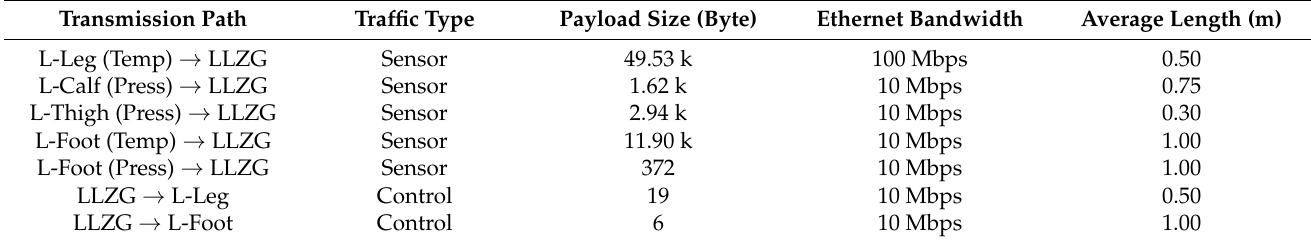
Table 9. Data transmission link parameters of the ZIRA Left Leg and Foot Zone.